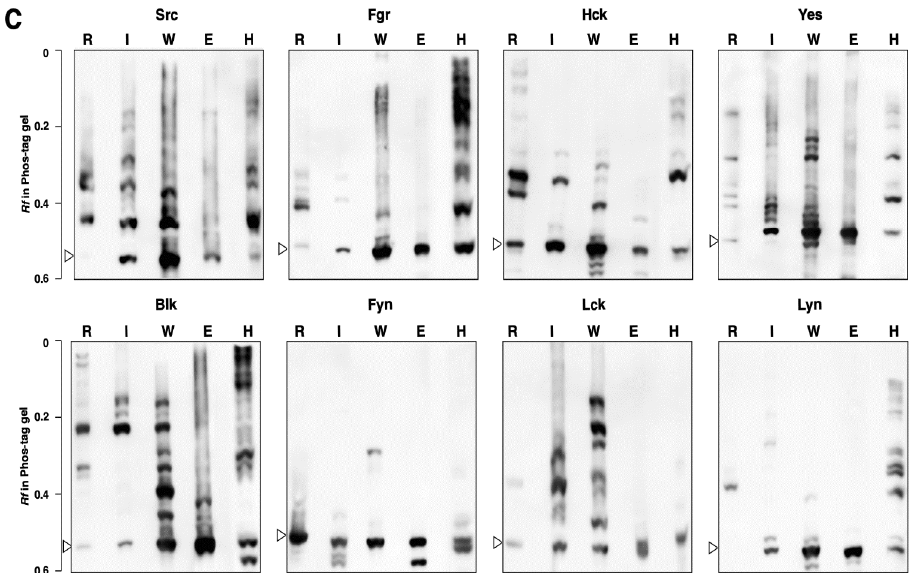
Figure 4. Phosphorylation status and tyrosine kinase activity of SFKs produced by cell-free protein expression systems. ( A ) Expression of SFKs by the T N T SP6 Quick Coupled Transcription/Translation System (a rabbit reticulocyte lysate sys- tem, lane R), the T N T T7 Insect Cell Extract Protein Expression System (lane I), the T N T SP6 High-Yield Wheat Germ Protein Expression System (lane W), the S30 T7 High-Yield Protein Expression System (an E. coli lysate system, lane E), and 293 cells (lane H) was confirmed by Western blotting with anti-FLAG antibody. ( B ) SFKs expressed by each cell-free protein expression system were purified by immunoprecipitation with anti-FLAG antibody-bound magnetic beads and then sub- jected to an in vitro GST-Srctide phosphorylation assay. For each reaction, 0, 10, 30, and 60 min reactions were applied in order from the left in Phos-tag SDS-PAGE gels (10% w / v polyacrylamide, 20 µM Zn 2+ –Phos-tag). The gels were analyzed by Western blotting with anti-GST antibody. ( C ) Phosphorylation status of SFKs expressed in cell-free protein expression systems and in 293 cells was analyzed by Phos-tag SDS-PAGE (7% w / v polyacrylamide, 20 µM Zn 2+ –Phos-tag), followed by Western blotting with anti-FLAG antibody. The open arrowheads show the positions of the unphosphorylated forms.